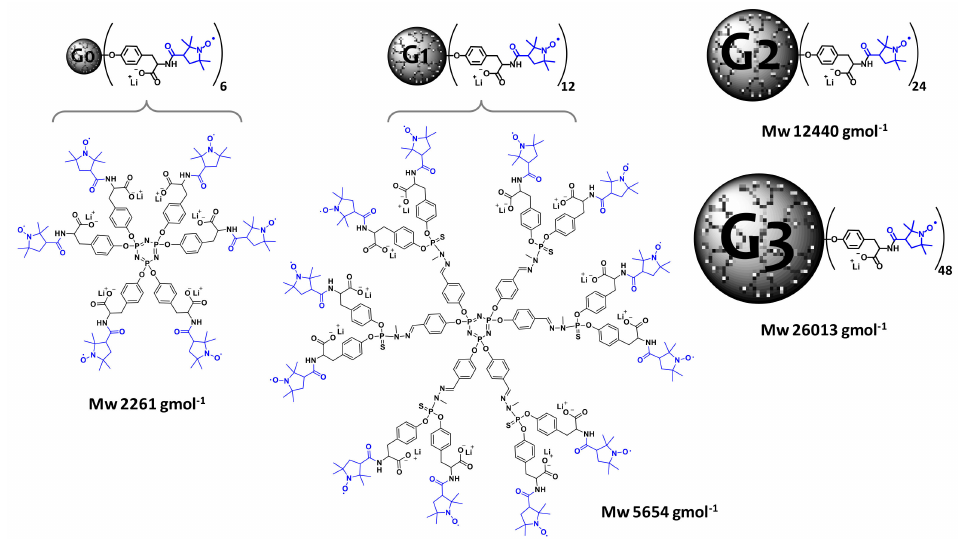
Figure 2. Structures of four generations of PPH Gn-Tyr-PROXYL (n = 0–3) radical dendrimers. Published by ACS Appl. Bio Mater. 2020 [21].